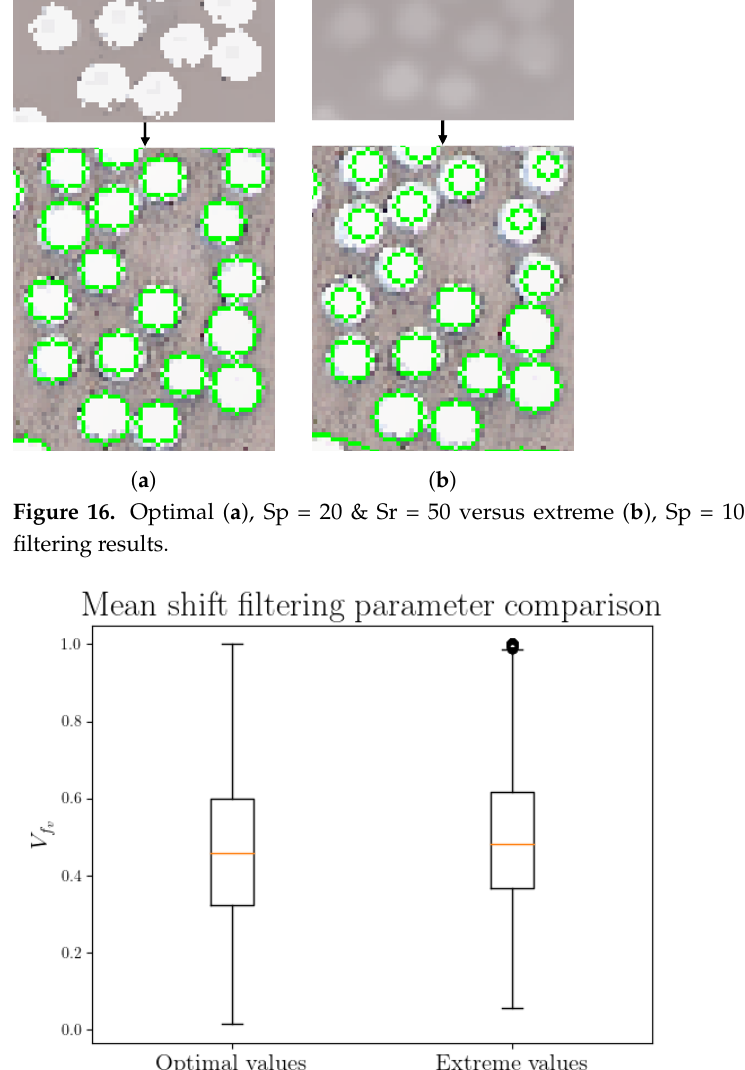
distribution over various micrographs using two parameter v